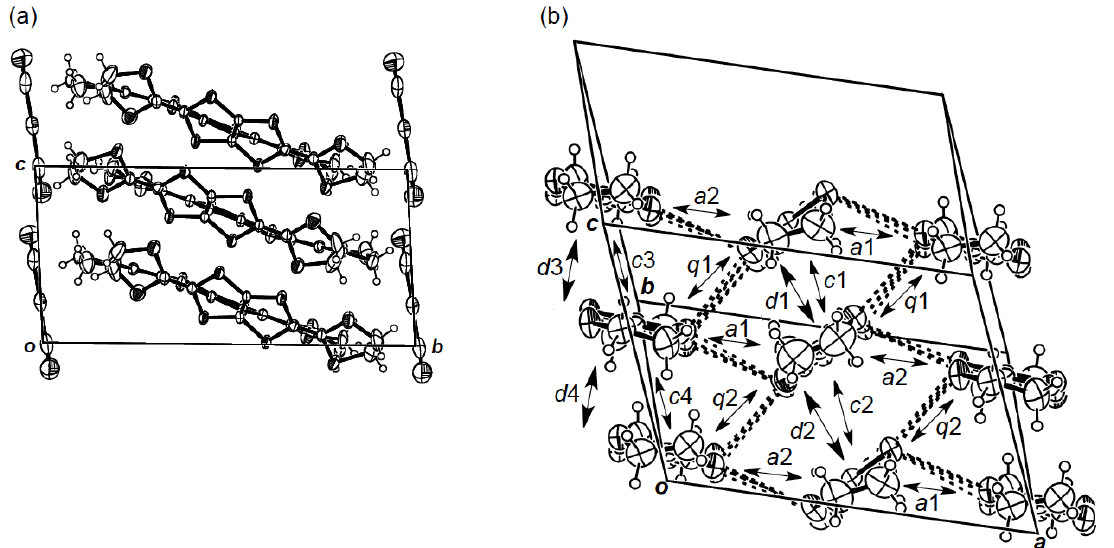
Au(CN) . ( c ) HOMO 2 2